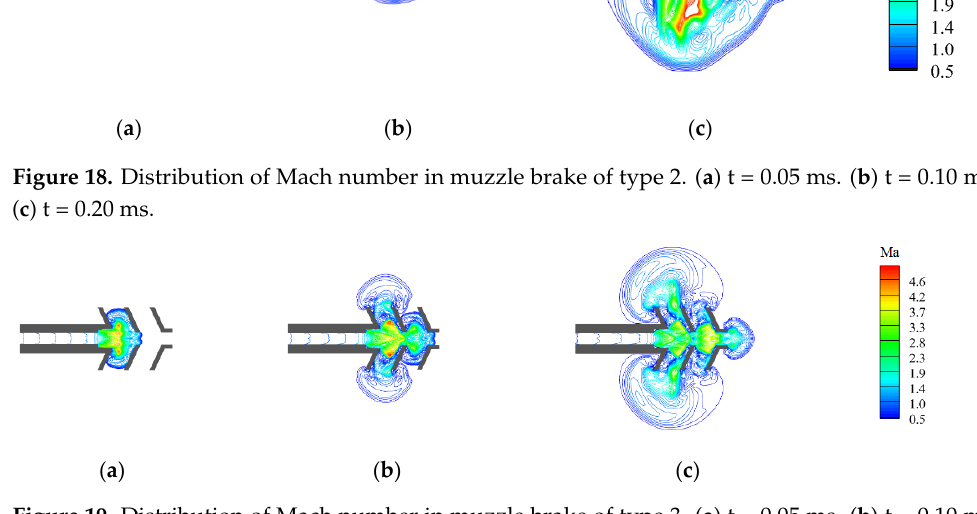
Figure 19. Distribution of Mach number in muzzle brake of type 3. ( a ) t = 0.05 ms. ( b ) t = 0.10 ms. ( c ) t = 0.20 ms.